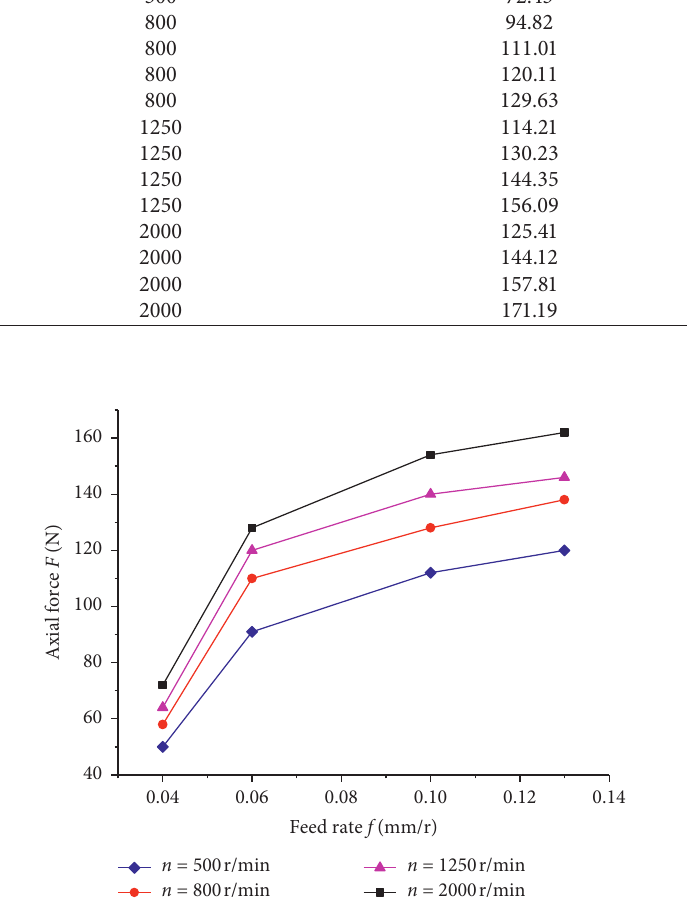
Figure 21: Axial force at the varying experimental